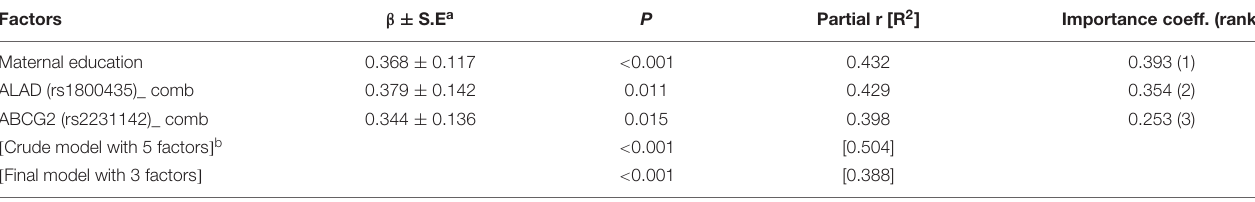
TABLE 5 | Factors associated with placental transfer rate of sumPFAS § (CATREG model).